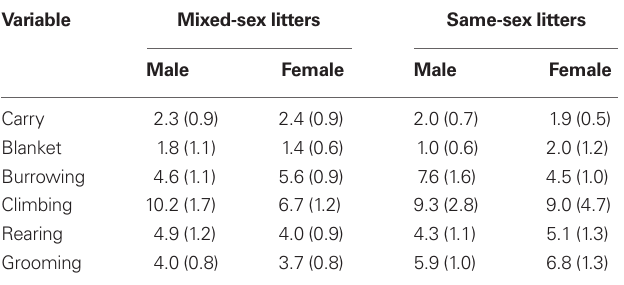
Table 3 | Mean ( ± SEM) total frequencies of each behavior across 10-min sessions conducted on PN7.